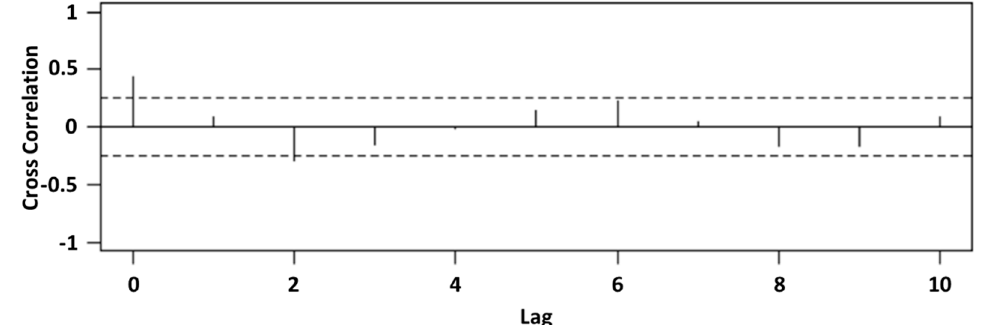
Figure 3. The cross - correlation diagram. Figure 3. The cross-correlation diagram.